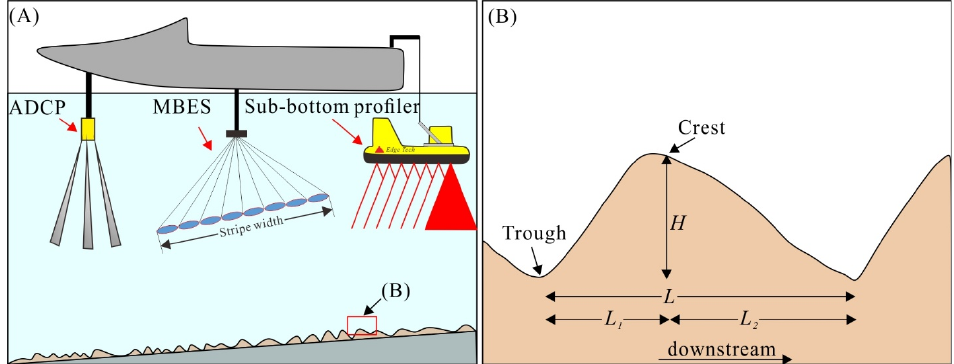
Figure 2. ( A ) Schematic diagram of instrument assembly related field measurements. ( B ) Definition of dune parameters.